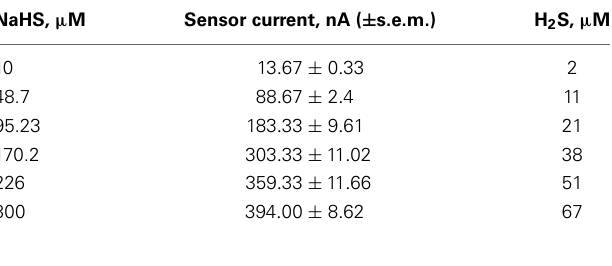
Table 1 | List of NaHS solutions prepared in standard bath solution (first row), the measured sensor current ± standard error of the mean (s.e.m.) (middle row) and the calculated amount of H 2 S (last row). NaHS, µ M Sensor current, nA ( ±